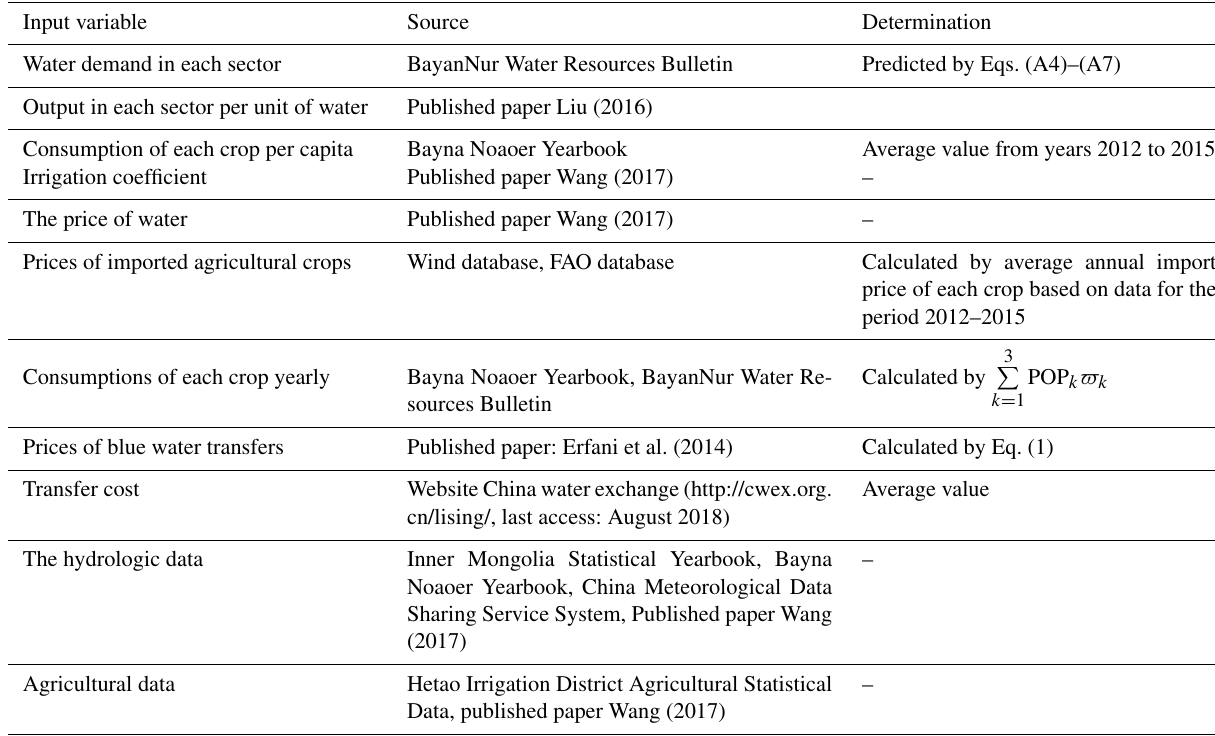
Table D1. Overview of input variables, data sources and